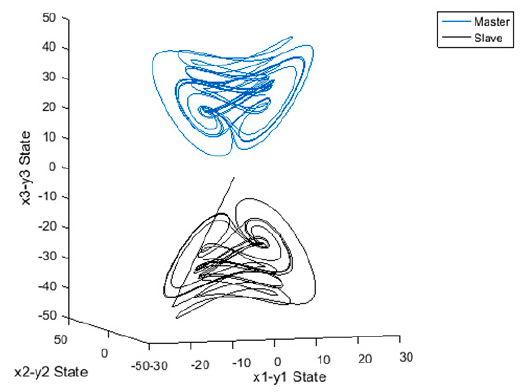
Figure 8. Phase space of anti-synchronization of an original master–slave